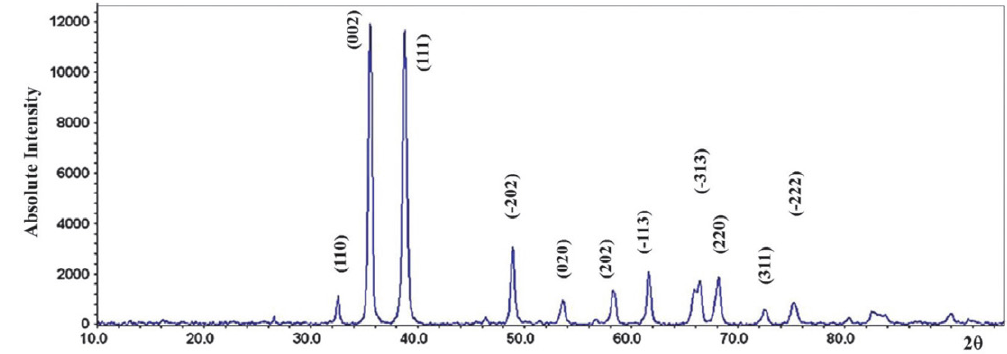
Figure 3 . X-ray diffraction pattern of CuO nanofibers calcined at 400 °C for 2 h (calcinated CuO